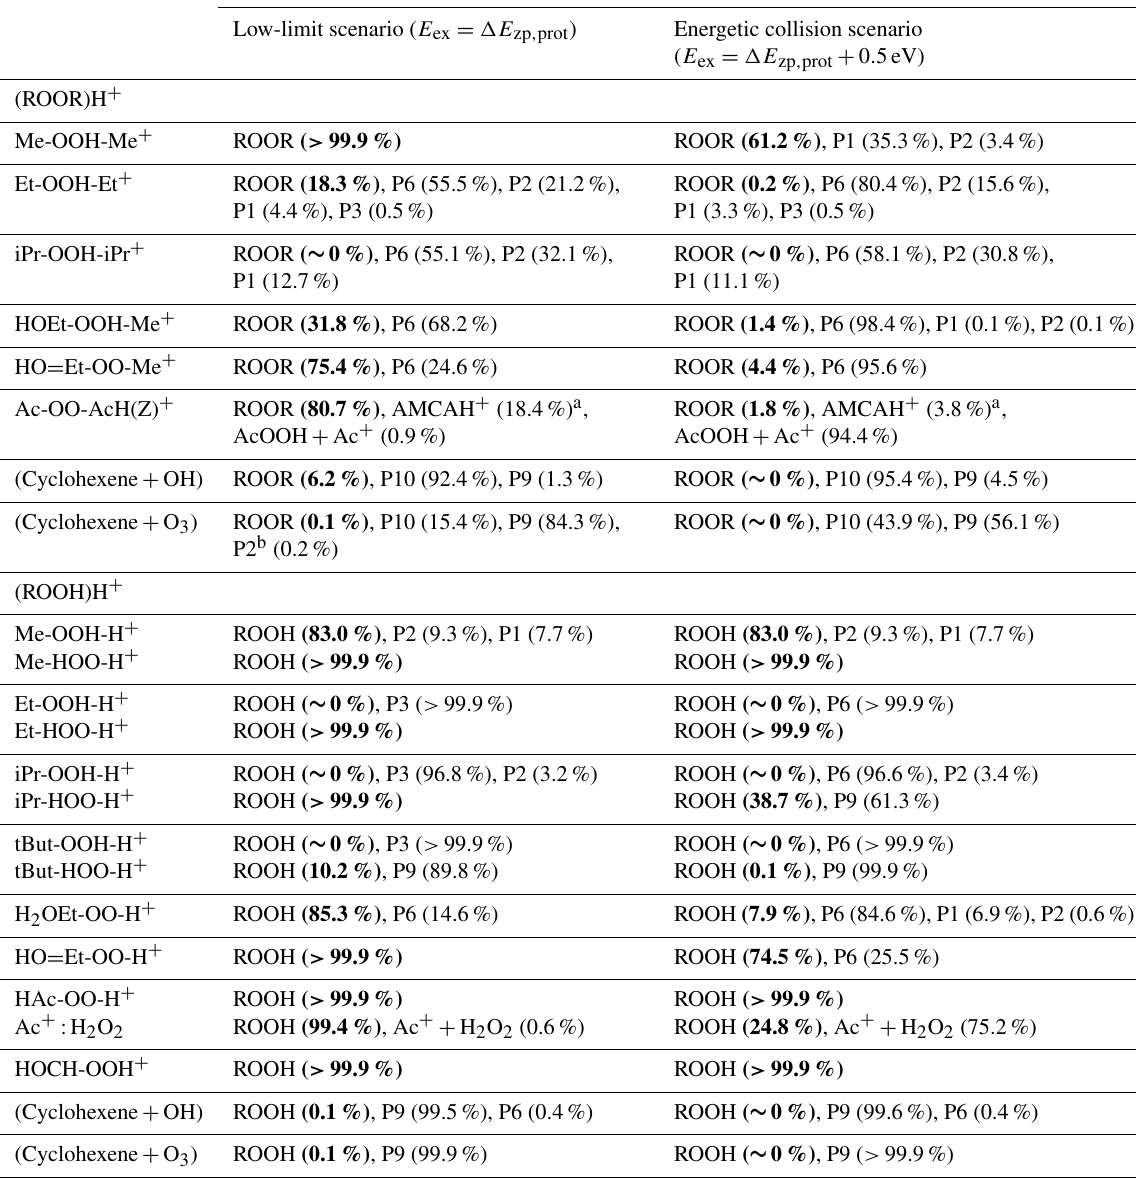
Table 1. Species distribution of each studied ROOR and ROOH obtained from reaction dynamics simulation after 100µs at 298.15K and 1.013mbar. Results are shown for two scenarios differing in the amount of excess internal energy ( E ex ) assigned to the initial reactant: (1) only protonation energy ( E ex = (cid:49)E zp , prot ) and (2) protonation energy plus reference energy value from high-speed collisions ( E ex = (cid:49)E zp , prot + 0 . 5eV). Percentage of unreacted ROOR and ROOH highlighted in